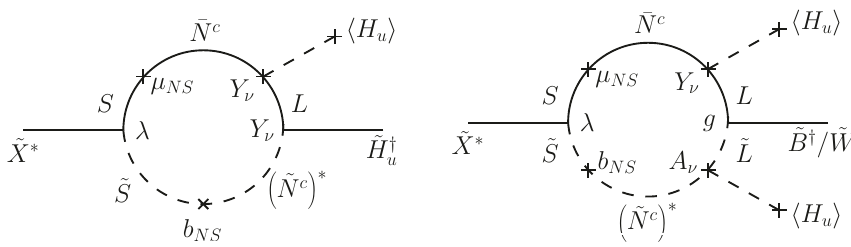
Figure 1 . Typical one-loop diagrams inducing a mixing between the Xino and the MSSM neu-